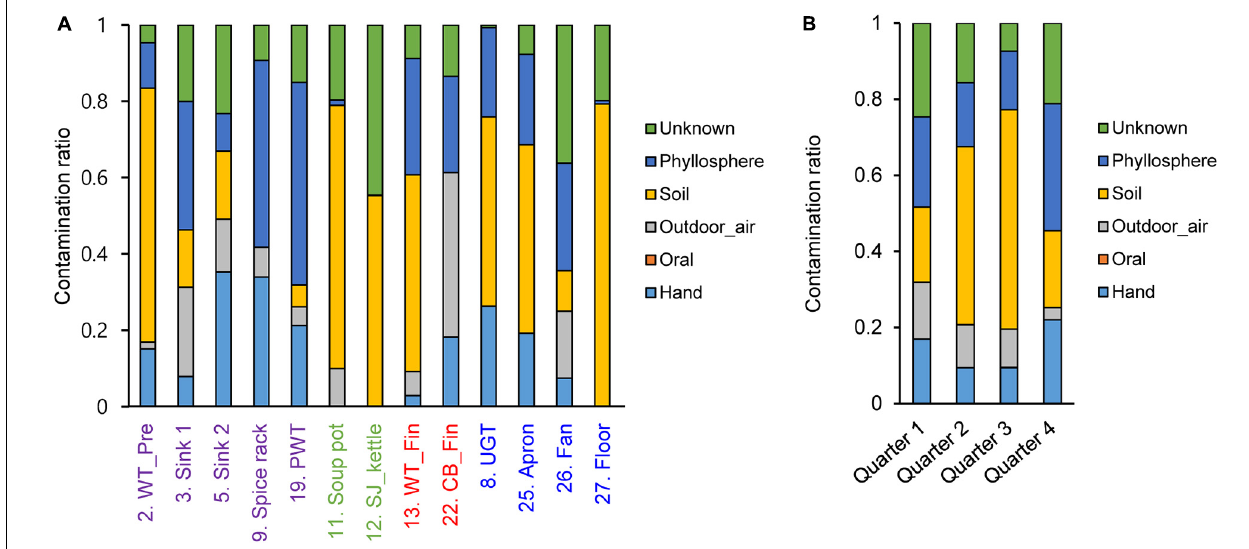
FIGURE 6 | Contamination ratio comparison from different sources to each surface (A) and each sampling time point (B) . The pre-preparation area, cooking area, final preparation area, and the cooking environment indicated as purple, green, red, and blue,